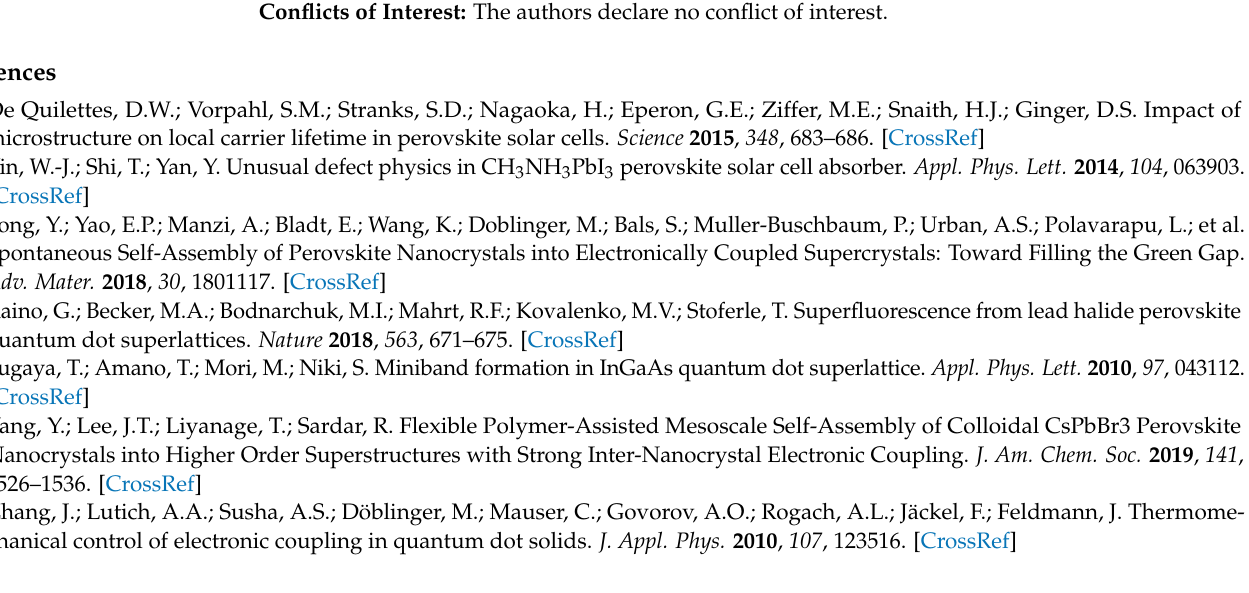
Rhodamine B; Table S5: Fitting parameters for MAPbBr 3 ; Table S6: Fitting parameters for FAPbBr 3 ; Table S7: Fitting parameters for CsPbBr 3 ; Figure S4: SEM micrographs and AFM height images of NCs; Table S8: Section analysis of AFM height